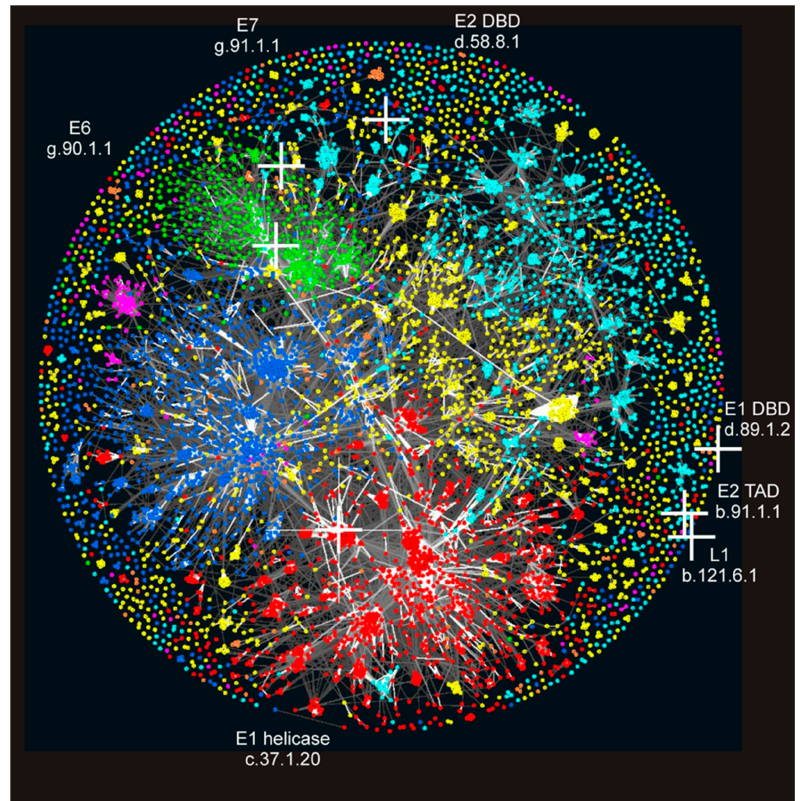
Figure 2. Location of PV domains in the “Galaxy of folds”. PV structural domains are marked by white crosses and visualised on protein domain space. Domains in Structural Classification of Proteins (SCOP) were clustered using the software CLANS based on their all-against-all pairwise similarities, as measured by HHsearch p -values [34]. Domains are coloured according to their SCOP class: all-a (blue); all-b (cyan); a/b (red); a + b (yellow), small proteins (green); multi-domain proteins (orange); and membrane proteins (magenta). PV protein domain name and SCOP identifier are